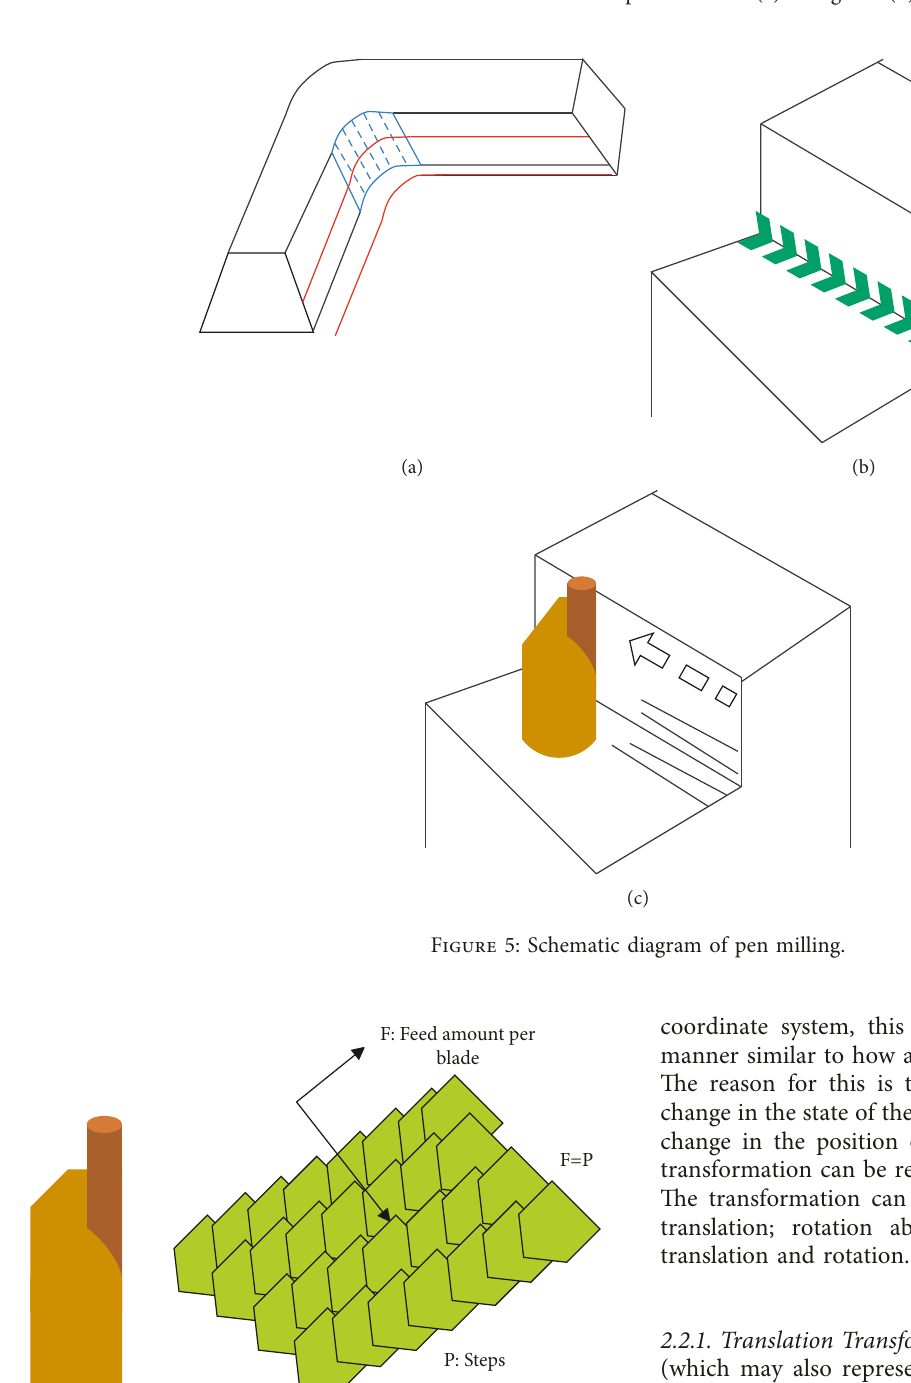
Figure 4: The effect of different feeds on the workpiece surface. (a) Not good. (b) Good. (c) Very good.